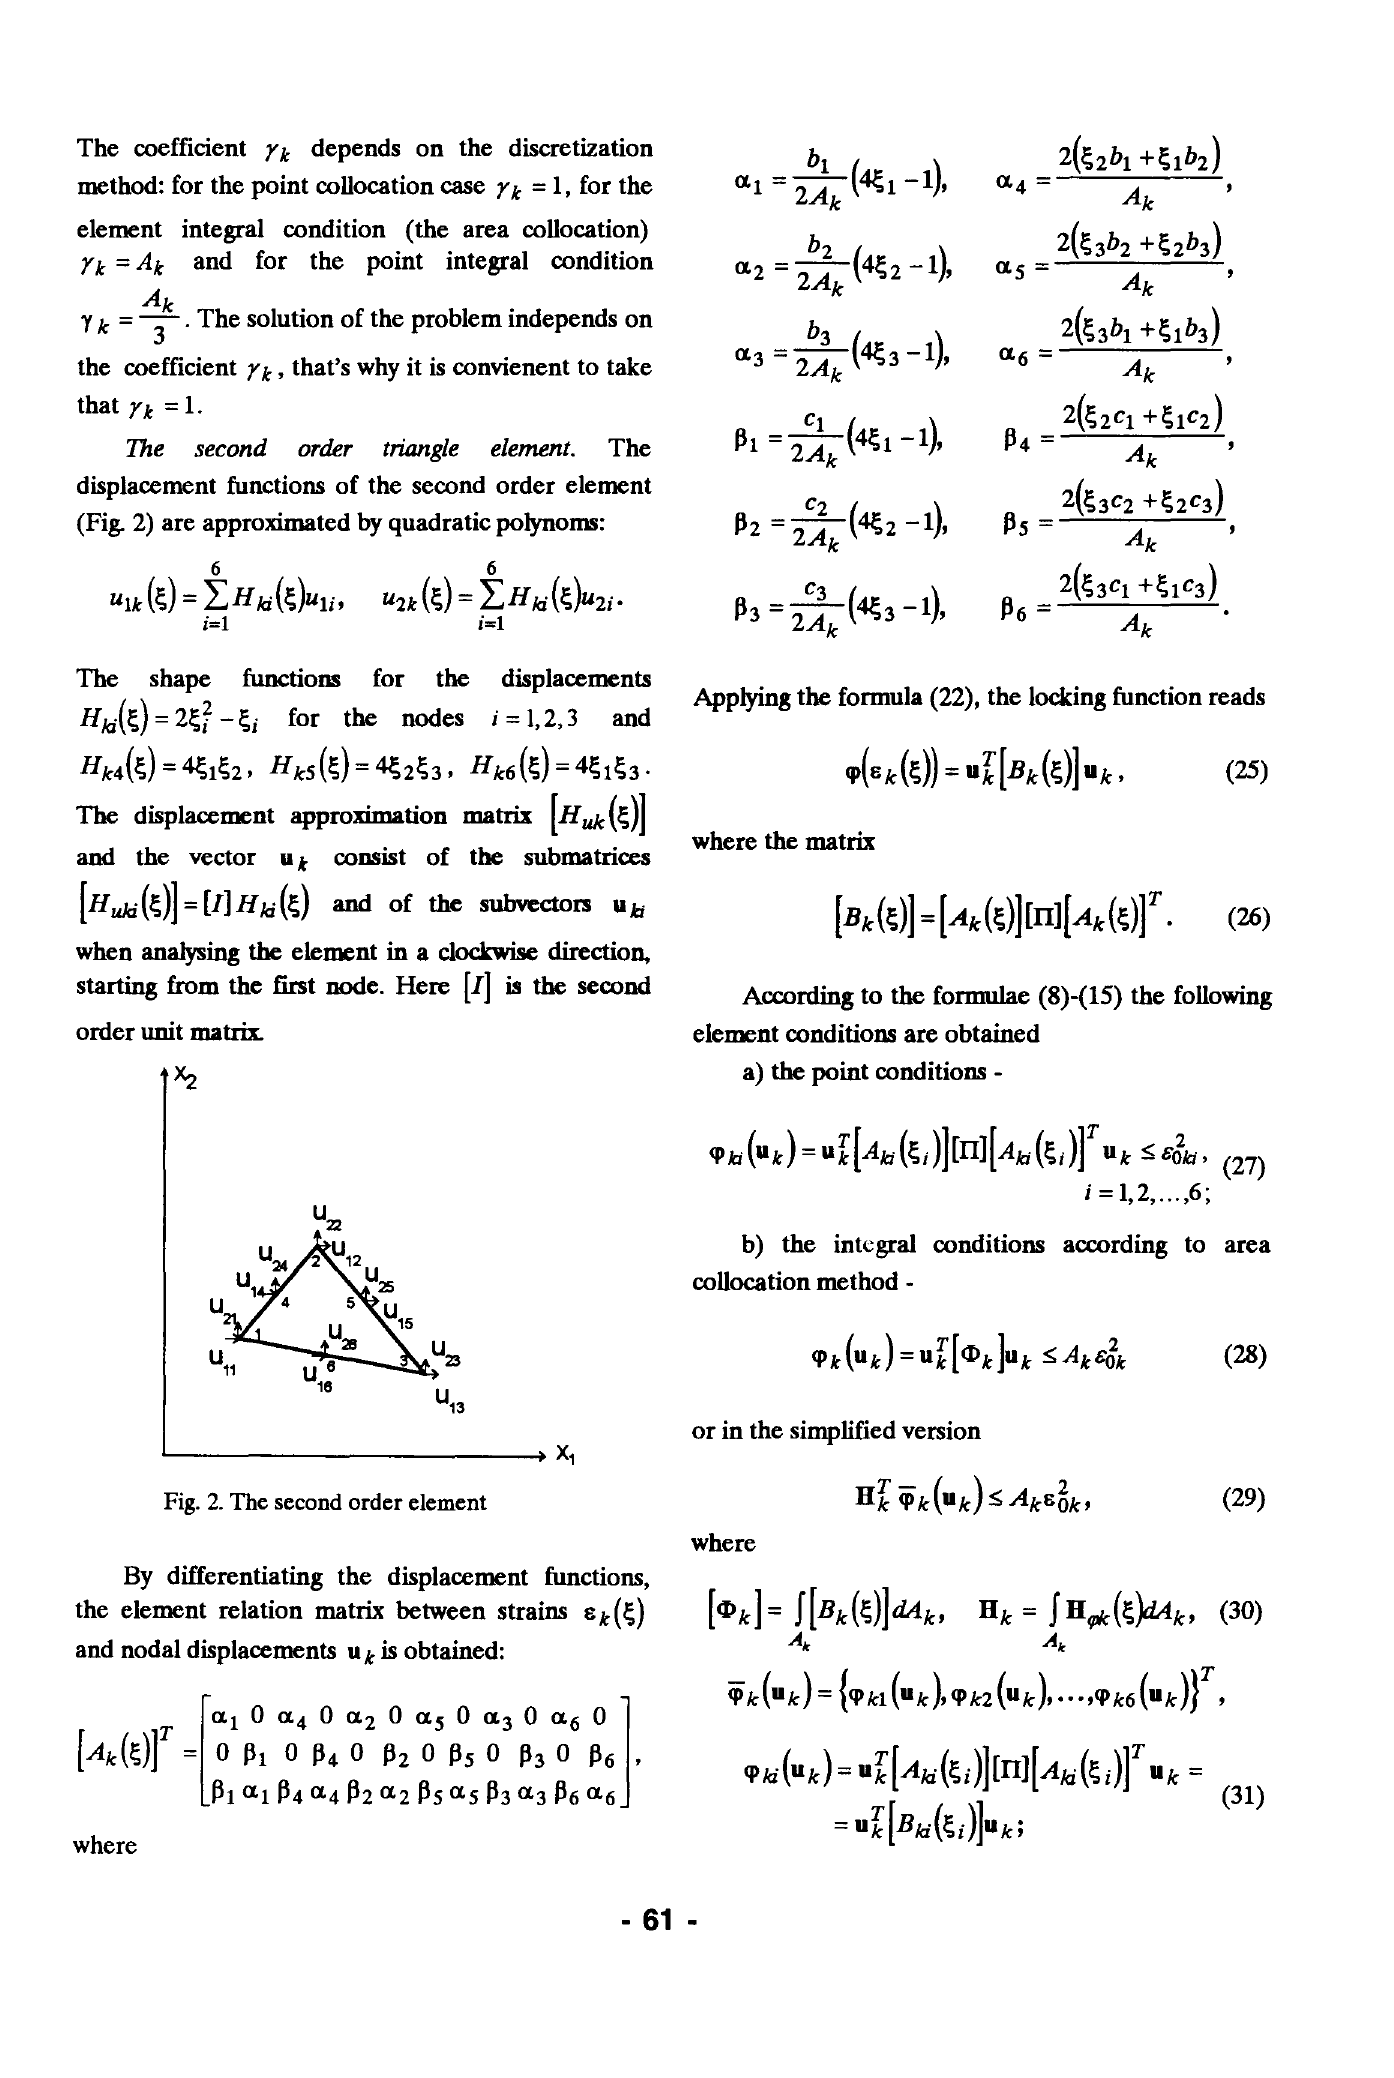
Fig. 2. The second order